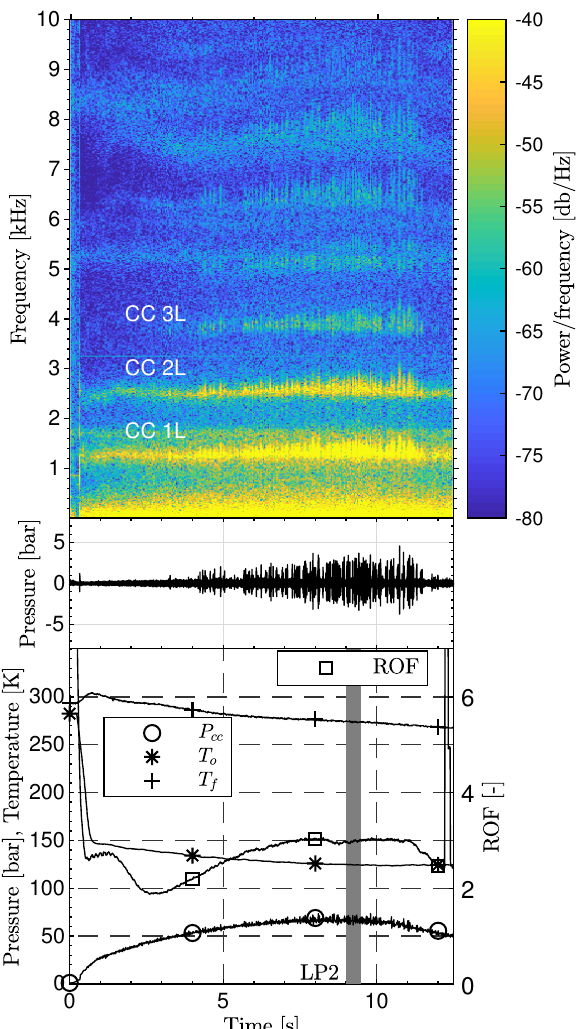
Figure 6. Test Sequences of second test with operating conditions and gray highlighted interval used for extracting the data for load point